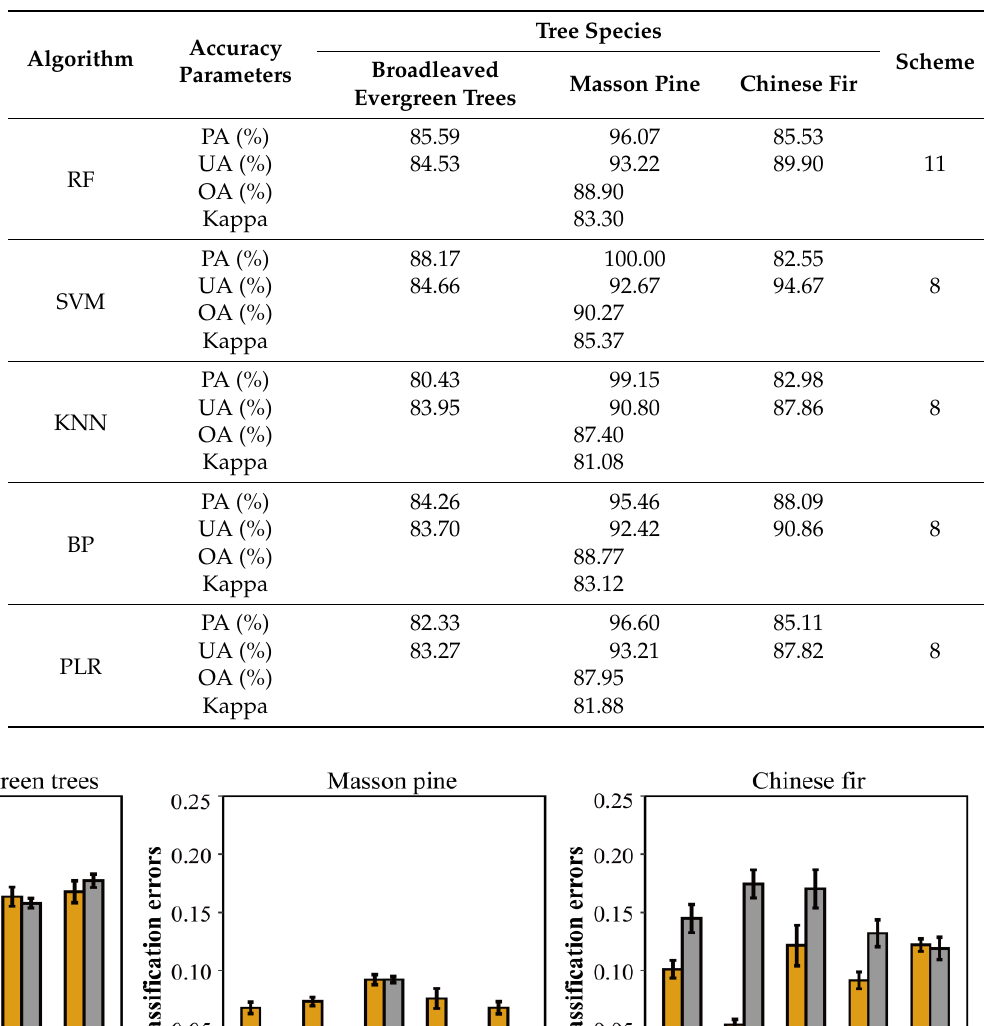
Table 8. Model precision table of optimal classification Scheme.